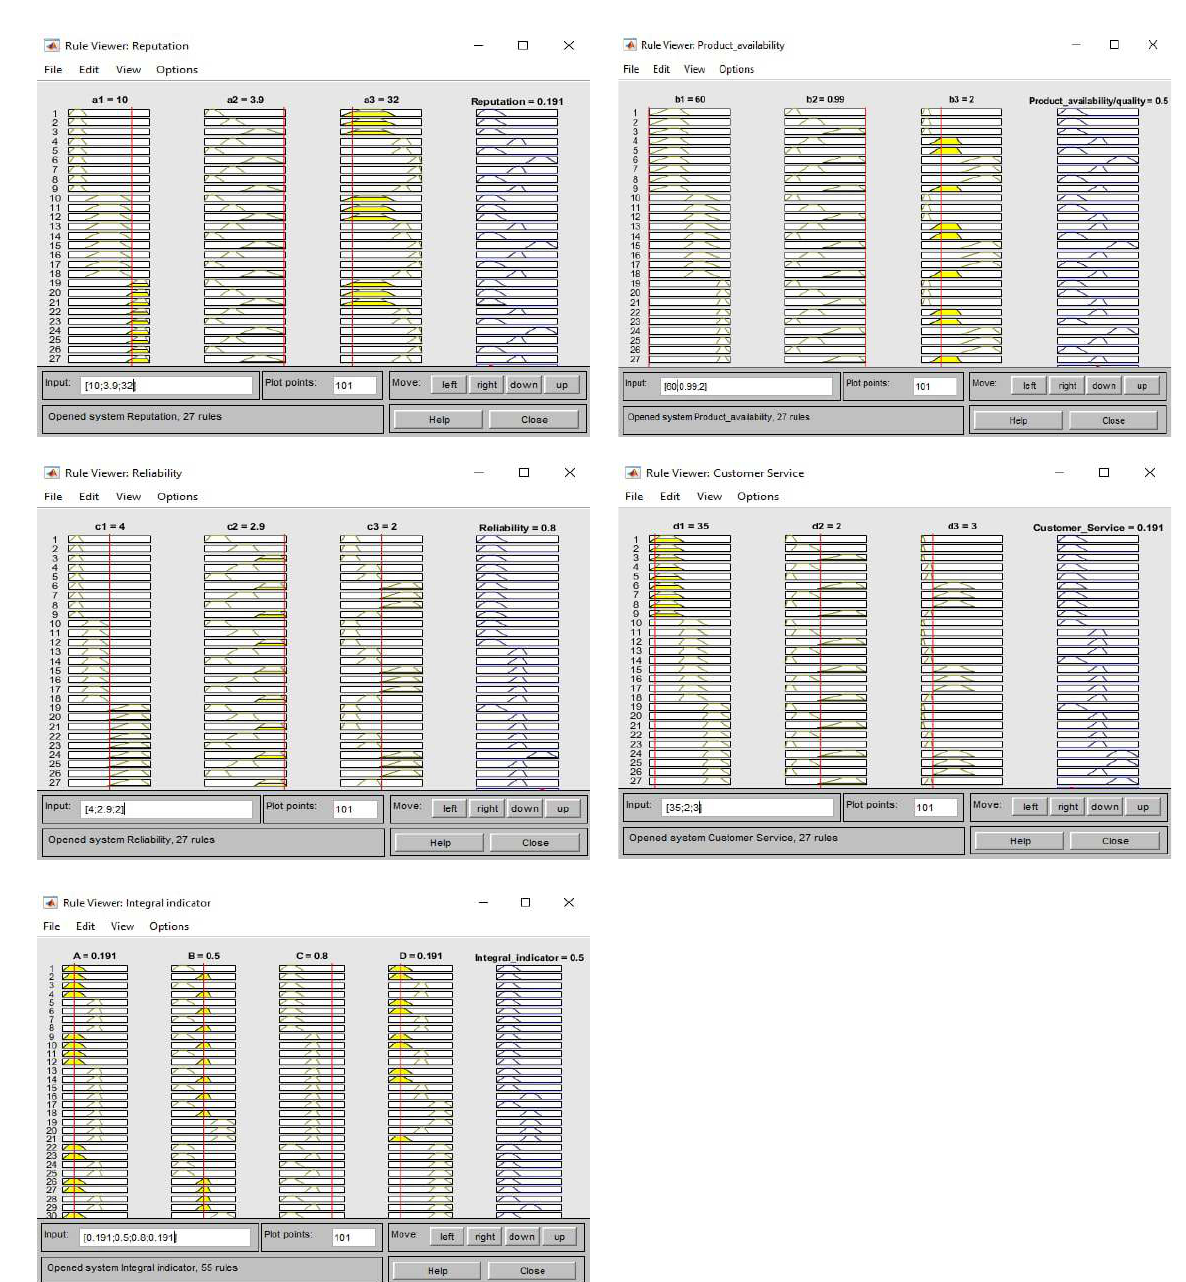
Figure A1. Realized defuzzification of data to the final level of the developed fuzzy model – an integral indicator of the quality of logistics service for Company No.